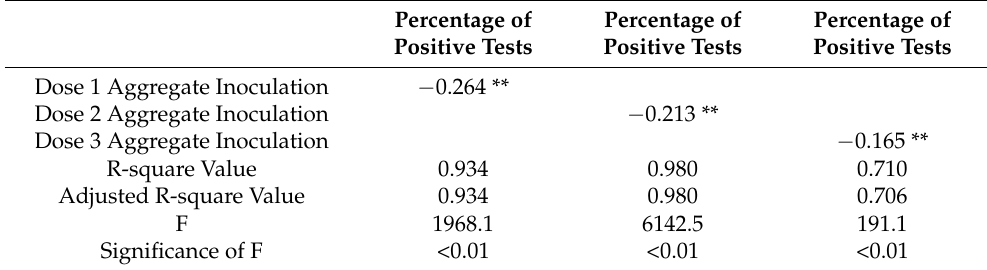
Table 13. Regression between the daily percentage of people who tested positive and doses 1, 2, and 3.